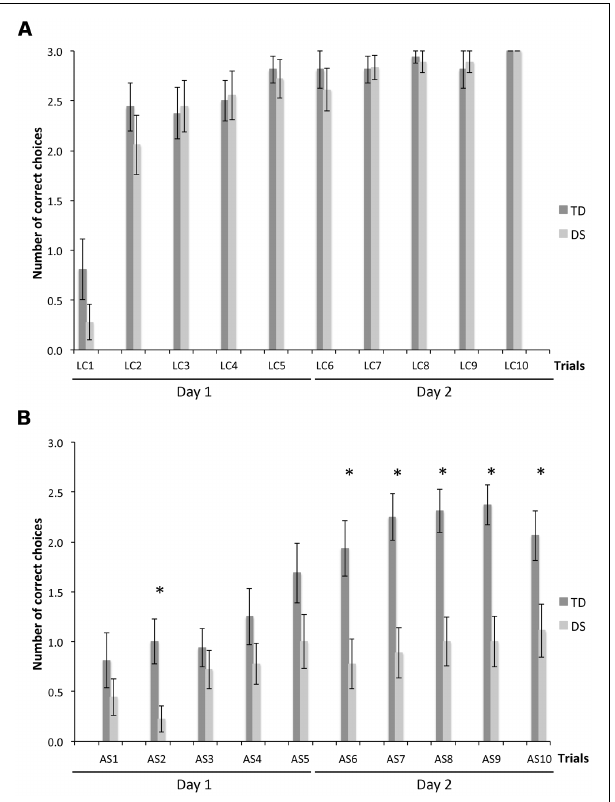
FIGURE 3 | Number of correct choices before erring (CBE), a measure of memory capacity. (A) LC trials. (B) AS trials.The asterisks denote statistically significant group differences on a given trial at p <